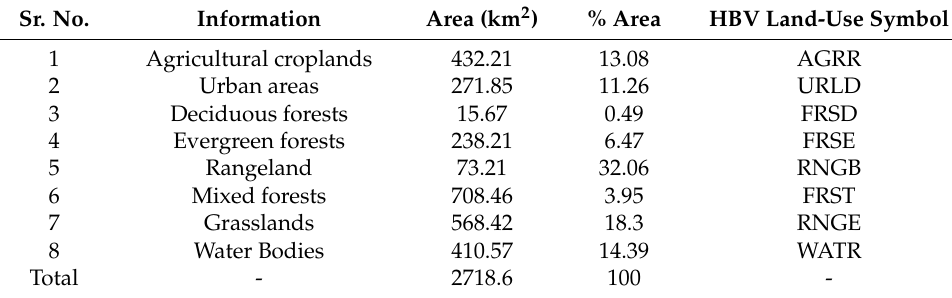
Table 3. Features of the Kunhar River land-use